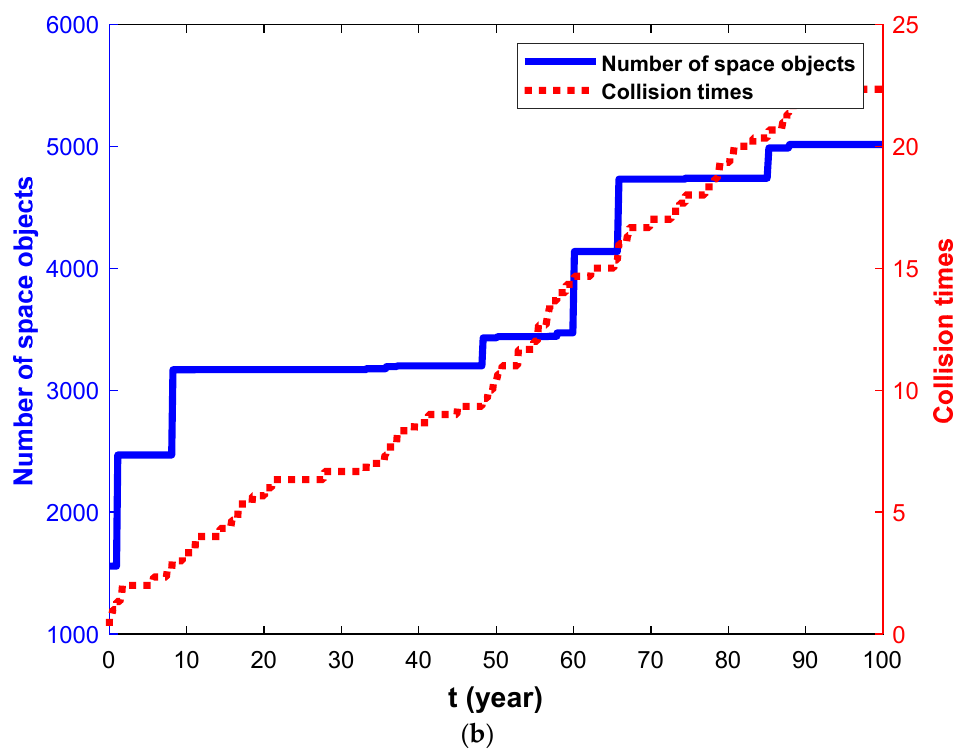
Figure 8. Two simulations of the fourth scenario: ( a ) simulation with the largest number of space objects after 100 years; ( b ) Simulation with the smallest number of space objects after 100 years.